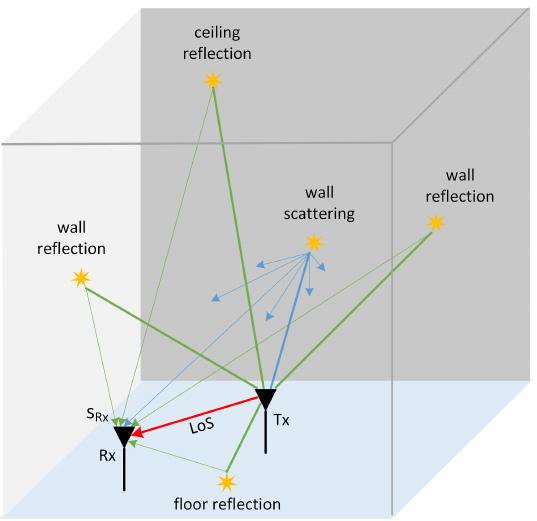
Figure 1. Multipath component propagation channels between Tx-Rx in an indoor